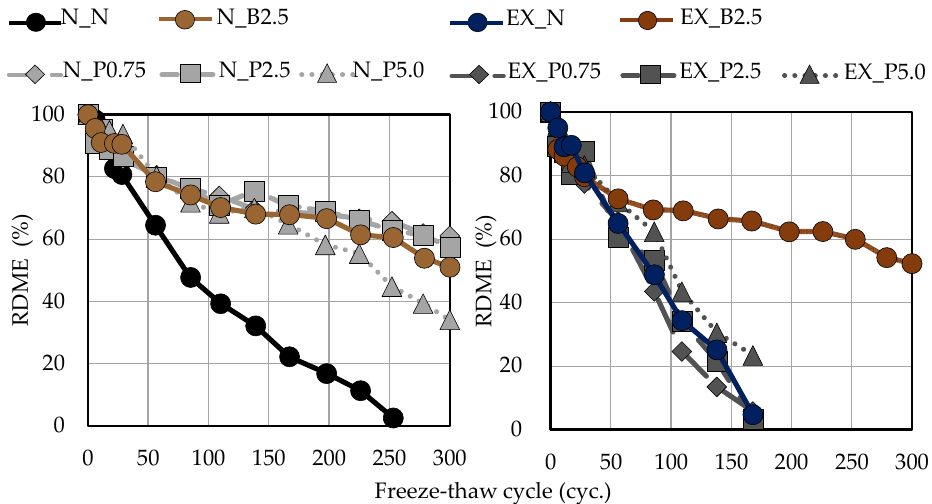
Figure 10. Relationship between RDME and the freeze-thaw cycle in ordinary and expansive mortars. (black: without NFBC, brown: with NFBC type B f , grey: with NFBC type P f )